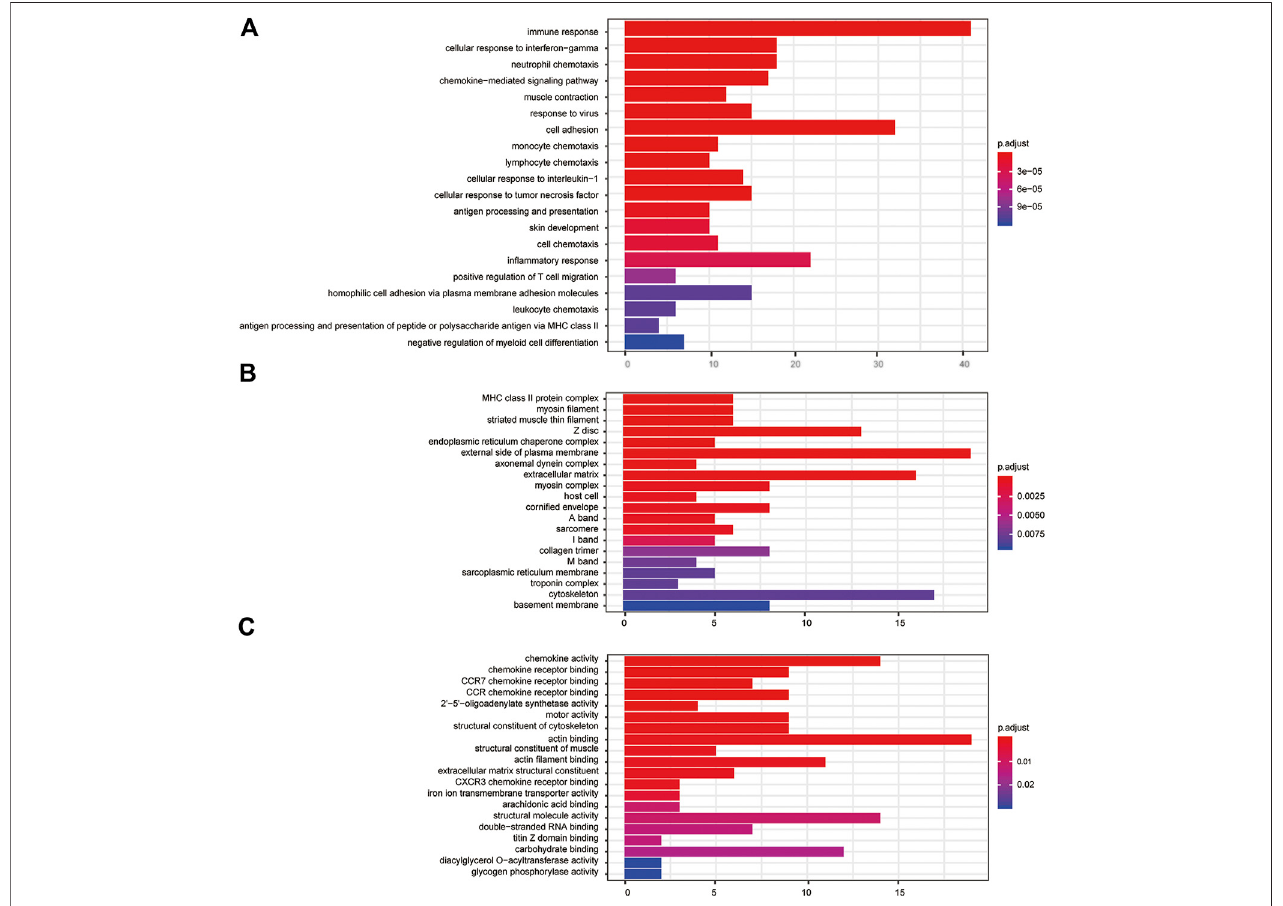
FIGURE 5 | GO analysis. (A) Barplots of the biological process enrichment result, (B) barplots of the molecular function enrichment result, and (C) barplots of the cellularcomponentenrichmentresult.Thecoloredentriesarethesigni fi cantaggregation( p < 0.05),and p valuesareshownontherightside.Thelowerthe p valueis,the more signi fi cant the enrichment is. The length of the bar means the number of genes in the signi fi cant aggregation.